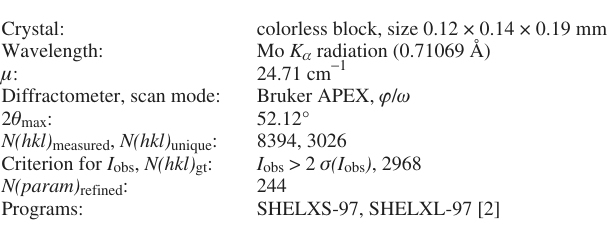
Table 1. Data collection and handling.